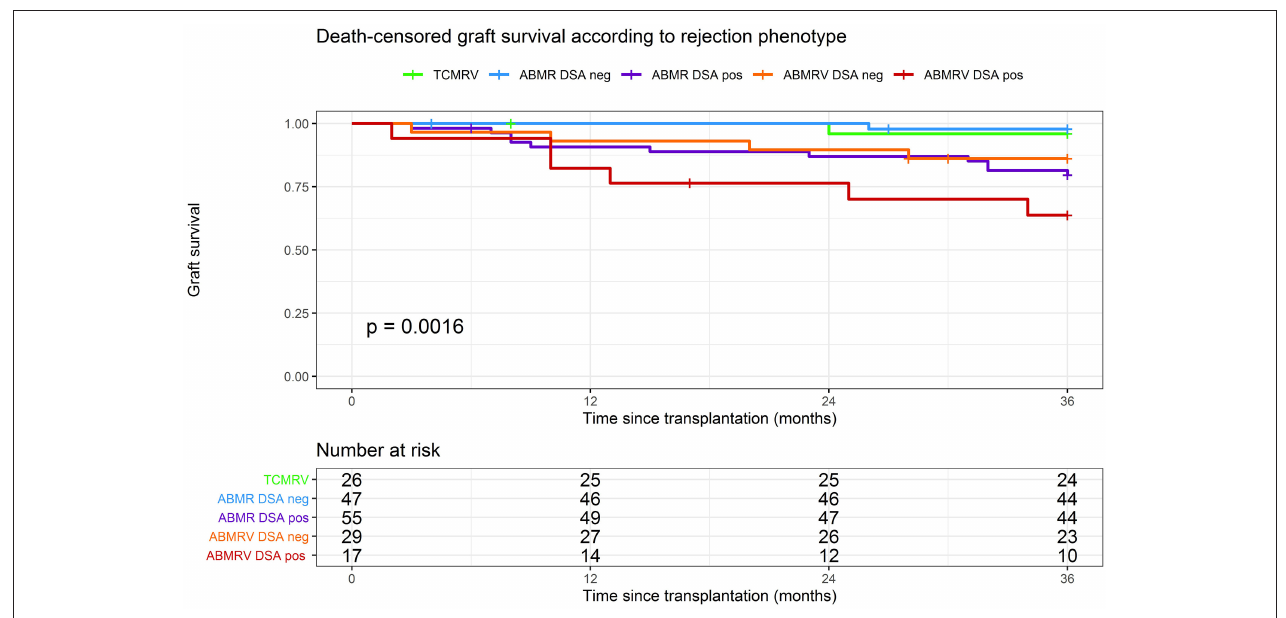
direct comparison of all rejection phenotypes. The study did not involve the evaluation of non-HLA antibodies or transcriptomic